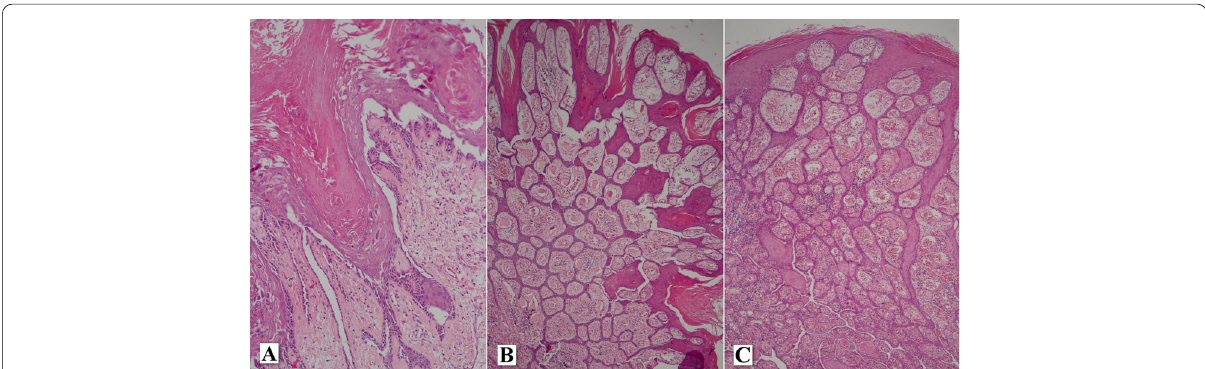
Fig. 3 Suprabasal acantholysis ( A : HE, 100x) and pseudoepitheliomatous hyperplasia with prominent anastomosing cords of elongated rete ridges (with a syringofibroadenoma silhouette) ( B and C : HE, 40x)